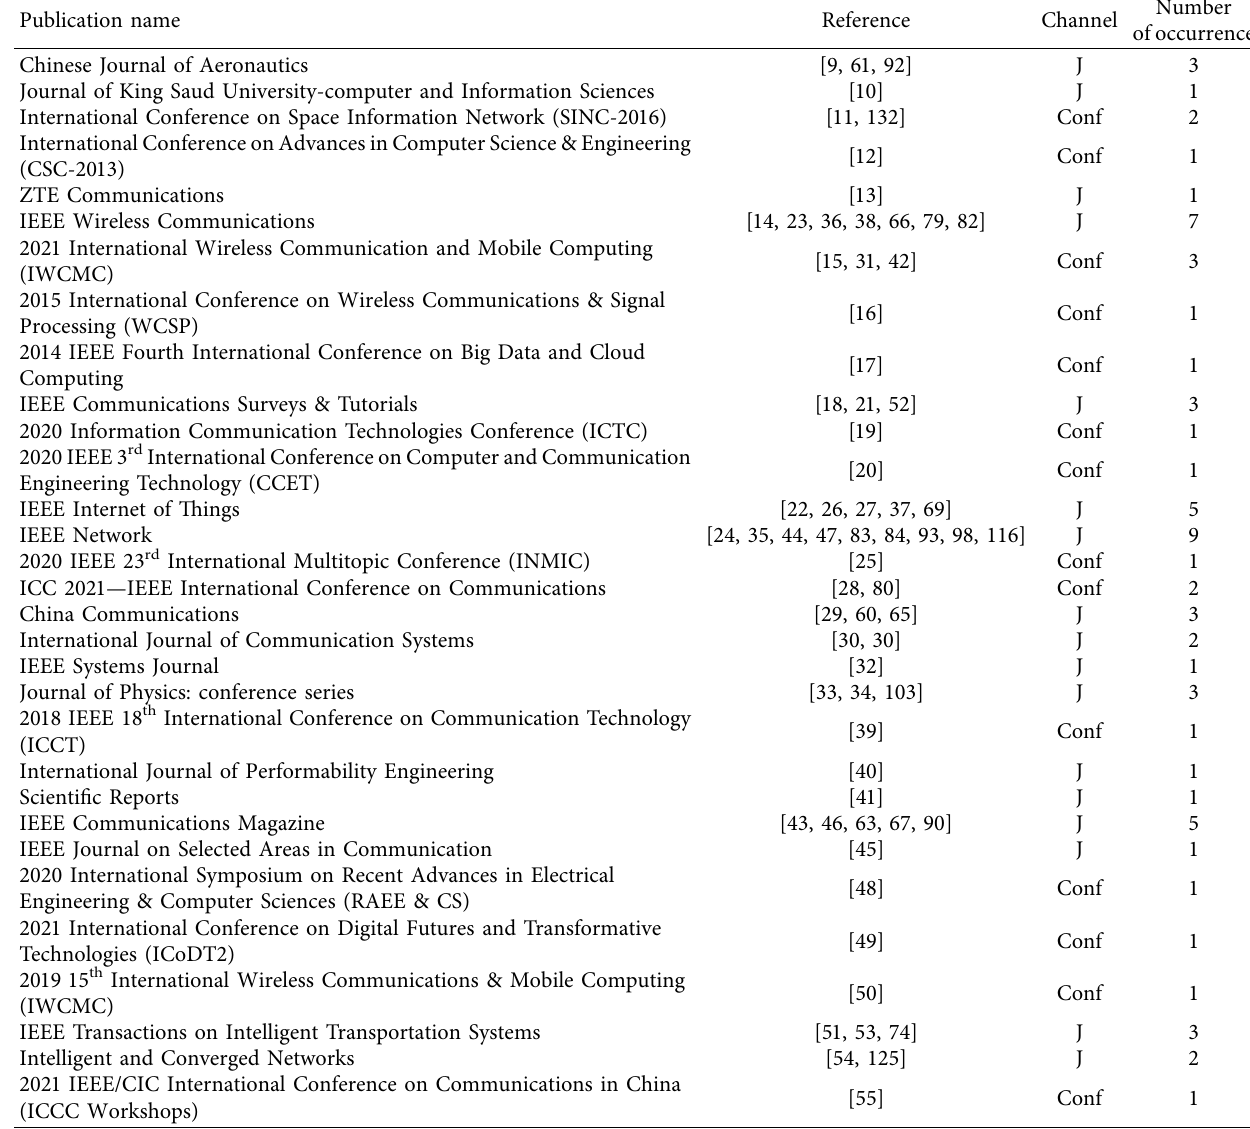
Table 5: Publication